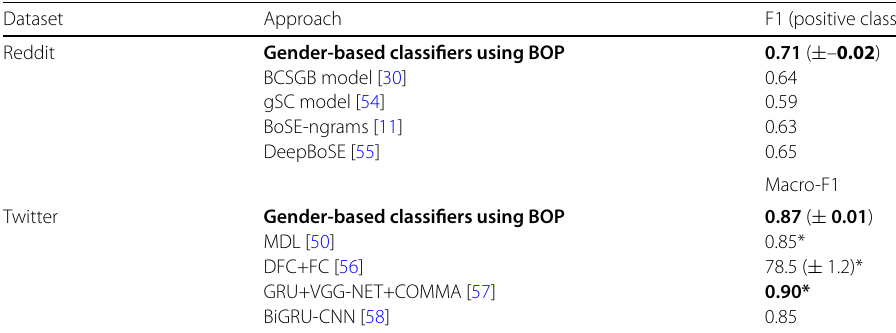
Table 4 Comparison of the performance of our gender-based classifiers with the BoP representation against state-of-the-art results. The results marked with an “*” correspond to approaches using both text and image